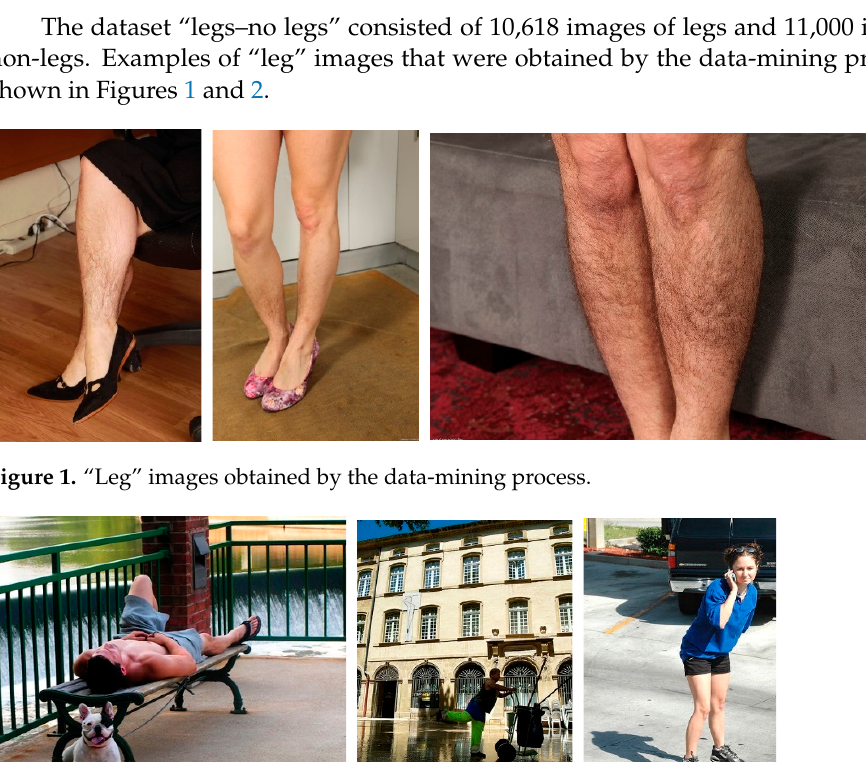
C6 Figure 3. Images of legs with CVD. All 11,118 images of legs were categorized by a certified phlebologist into 7 CEAP classes (C0–C6). After classification, the distribution of images by CEAP classes was: C0— 872, C1—2810, C2—1493, C3—3743, C4—1530, C5—403, C6—267. The ratio of the number of images in each class to the total number of images in the dataset is shown in Figure 4.